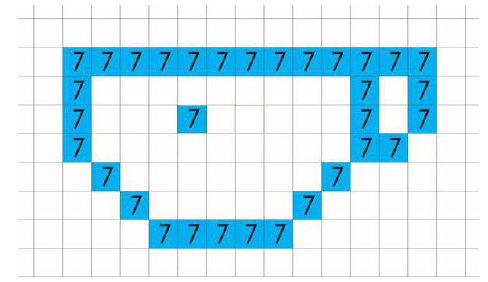
Fig. 13. Labeling example (with correct threshold). Fig. 14. Select target area using MuSSE. Source: MuSSE with sprite sheet